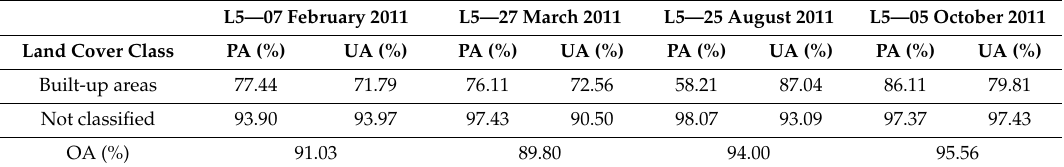
Table 17. OA, PA, and UA obtained computing SwiRed index on the images acquired by Landsat 5 mission. UA, user’s accuracy; PA, producer’s accuracy; OA, overall accuracy.